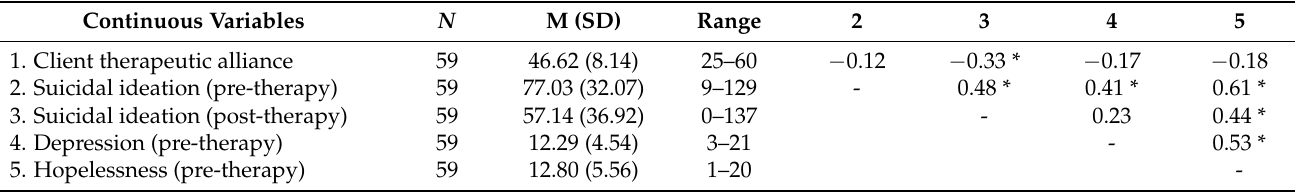
Table 2. Descriptive statistics and correlation coefficients for variables in hierarchical linear regression model 2.